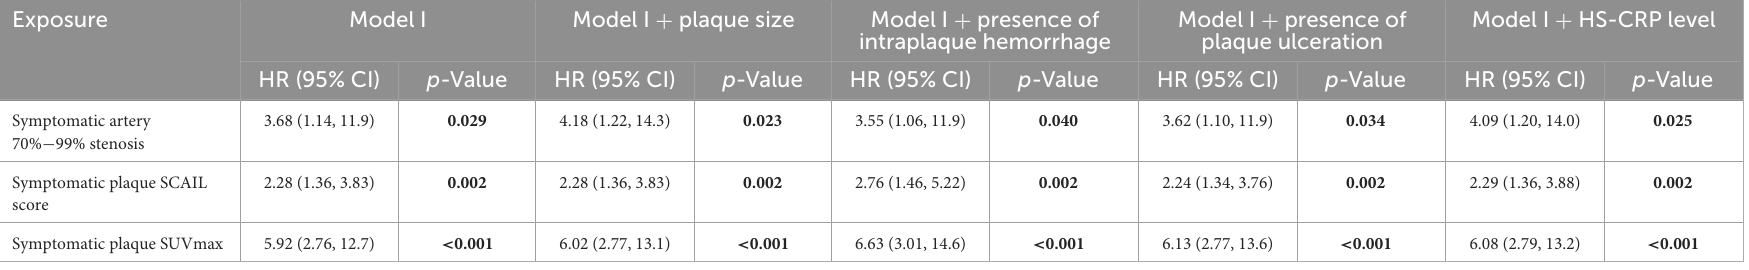
TABLE 2 Cox proportional-hazards models analyzing the association between 90-day ipsilateral ischemic stroke and symptomatic plaque stenosis severity, SCAIL score, and SUVmax. Exposure